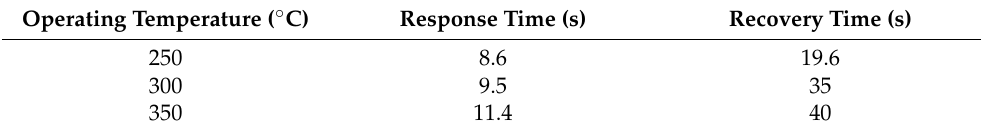
Figure 4. Gas response versus operating temperature for the ( a ) uncoated CuO structures, grown by sputtering; and ( b ) CuO structures, grown by sputtering and then coated with PV4D4 thin film. ( c ) Dynamic responses to 100 ppm of 2-propanol for the CuO structures with PV4D4 thin film. Gas response versus operating temperature for the ( d ) uncoated Al 2 O 3 /CuO structures, grown by ALD/SCS; and ( e ) Al 2 O 3 /CuO structures, grown by ALD/SCS, then coated with PV4D4 thin film on top. Gas response versus operating temperature for the TiO 2 structures, grown by ALD, then coated with PV4D4 thin film. The investigated TiO 2 structures are ( f ) 15 nm and ( g ) 25 nm thick. Table 1. Response and recovery times of CuO structures with PV4D4 coating to 2-propanol